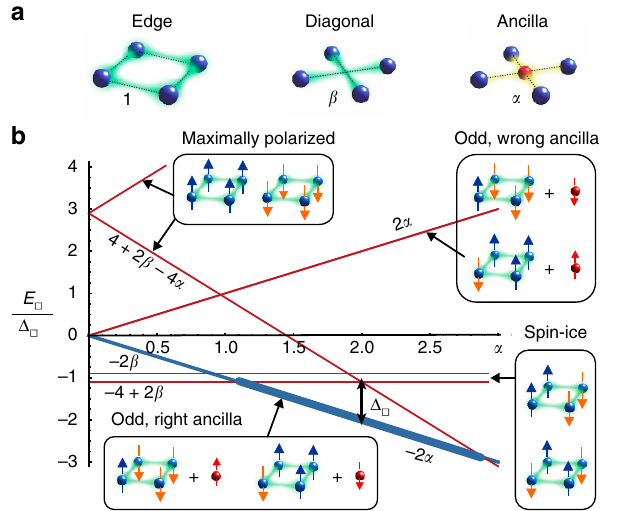
Figure 2 | Parity plaquette constraints. ( a ) Four-body interactions between physical spins (blue) of the same plaquette are constructed from two-body interactions between physical spins of strength 1 along the edge of the plaquette (left), interactions of strength b along the diagonal (middle) and additional interactions of strength a between an ancilla qubit (red) located at the centre of each plaquette and the surrounding physical qubits (right). ( b ) Eigenenergies E & of the Hamiltonian of equation (3), as a function of the physical spin-ancilla interaction strength a for a particular b t 1. Odd parity eigenstates with the right (lower left inset) or wrong (upper right inset) ancilla orientation have an energy ± 2 a . The maximally polarized states with all four physical spins up or down (upper left inset) have energy 4 þ 2 b (cid:4) 4 a , while the spin-ice states are independent of the ancilla interaction a and have constant energies (cid:2) 2 b and (cid:2) 4 þ 2 b . The thick blue line indicates the window of interest where the odd parity states are the ground states of the plaquette Hamiltonian.